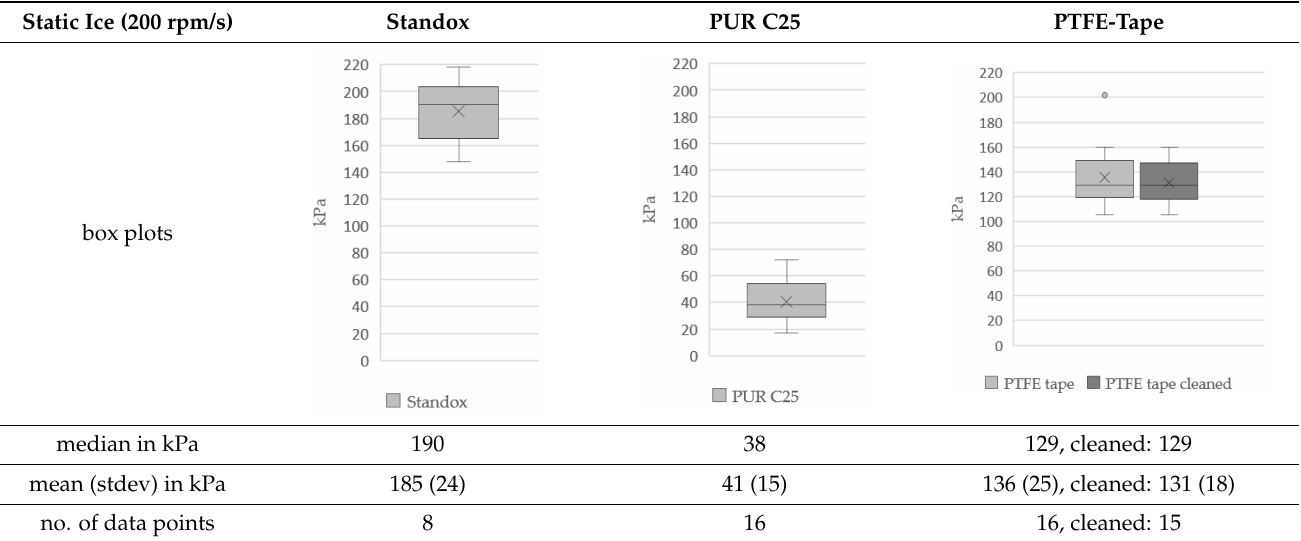
Table 8. Ice adhesion centrifuge test results for static ice (200 rpm/s) with relevant statistical data for result evaluation (given “cleaned” values base on outlier replacements after box plot